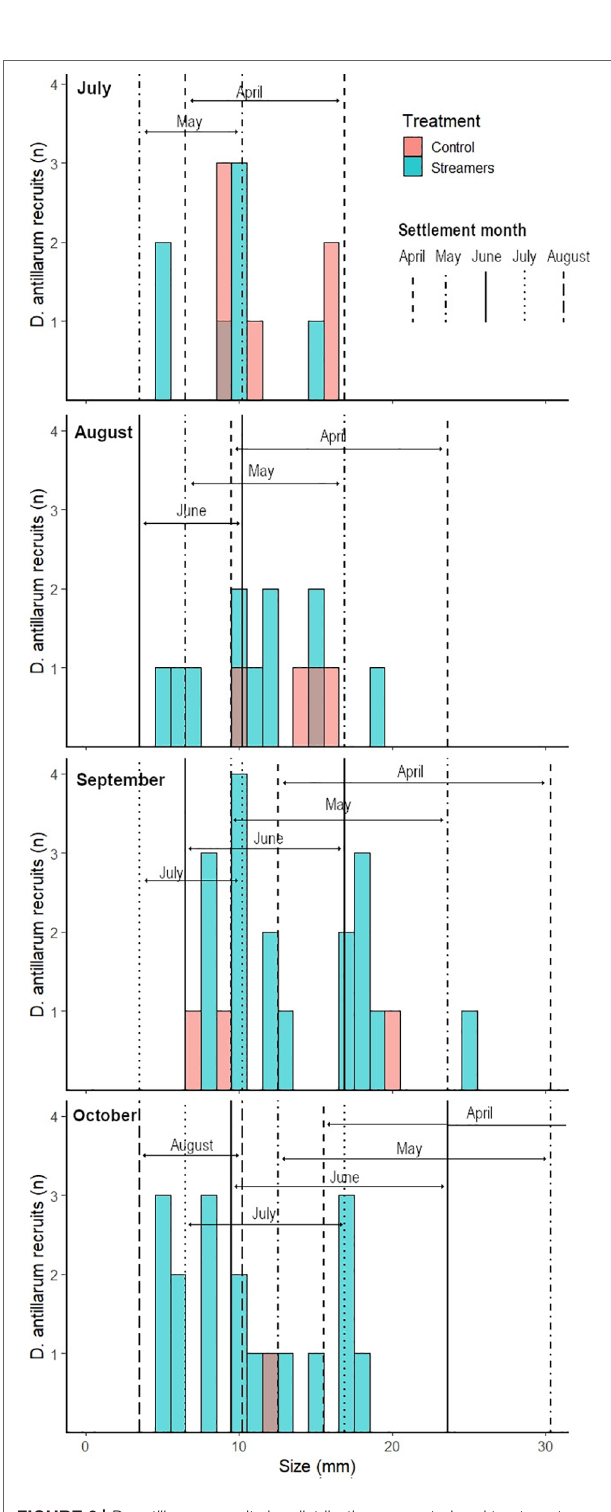
FIGURE 6 | D. antillarum recruit size distribution on control and treatment reefs per monitoring month. The area between vertical lines of the same type (dashed, solid, dotted, etc.) indicate the estimated size range per settlement cohort, based on growth rates from Idrisi et al. (2003) and Randall et al